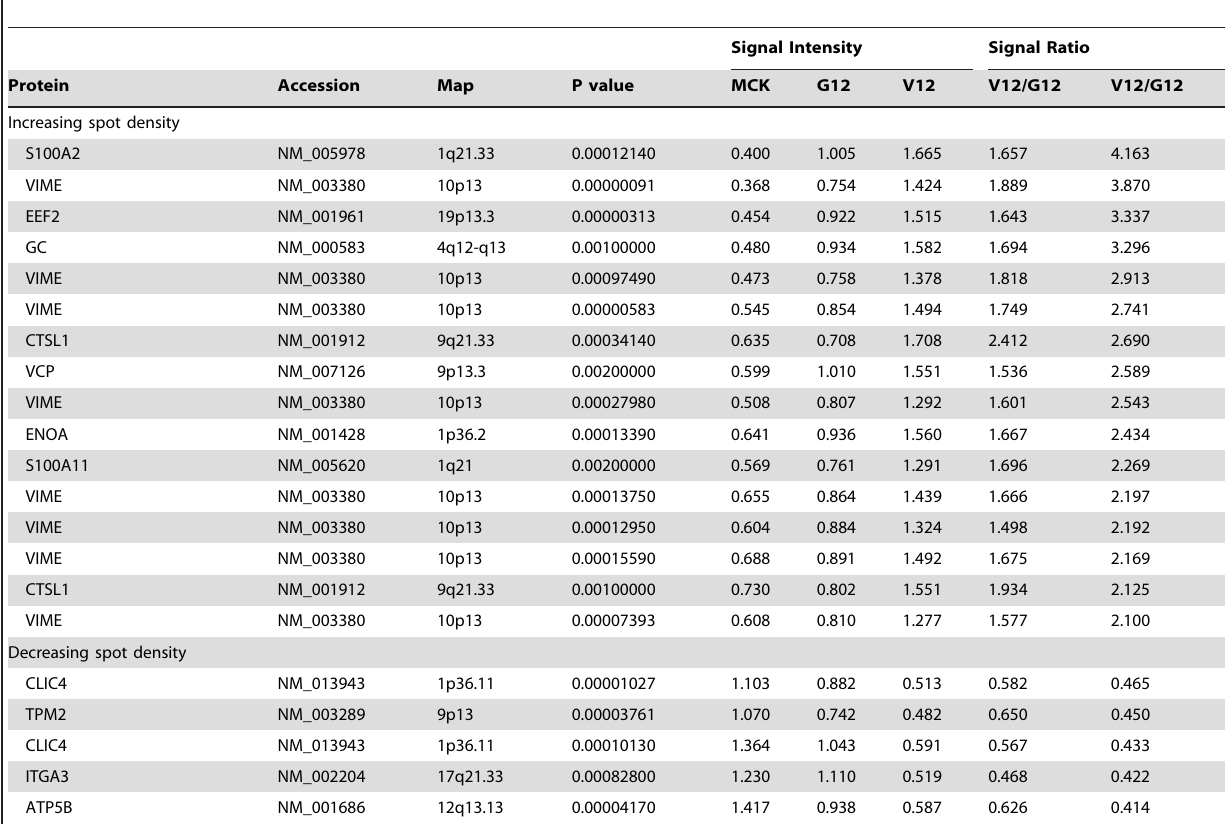
Table 1. Differentially expressed or modified proteins by oncogenic